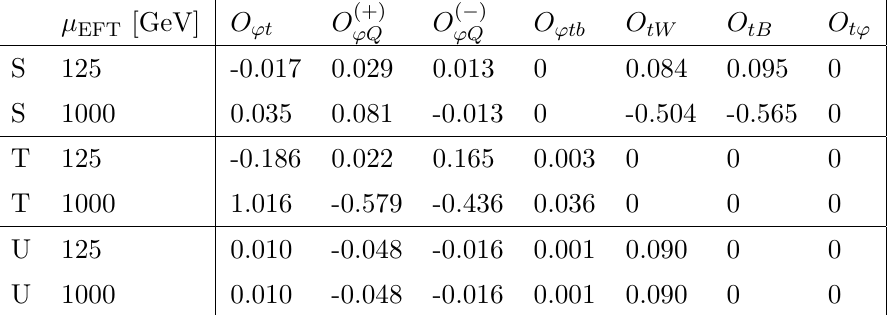
Table 6 . Deviation in S , T and U parameters due to top